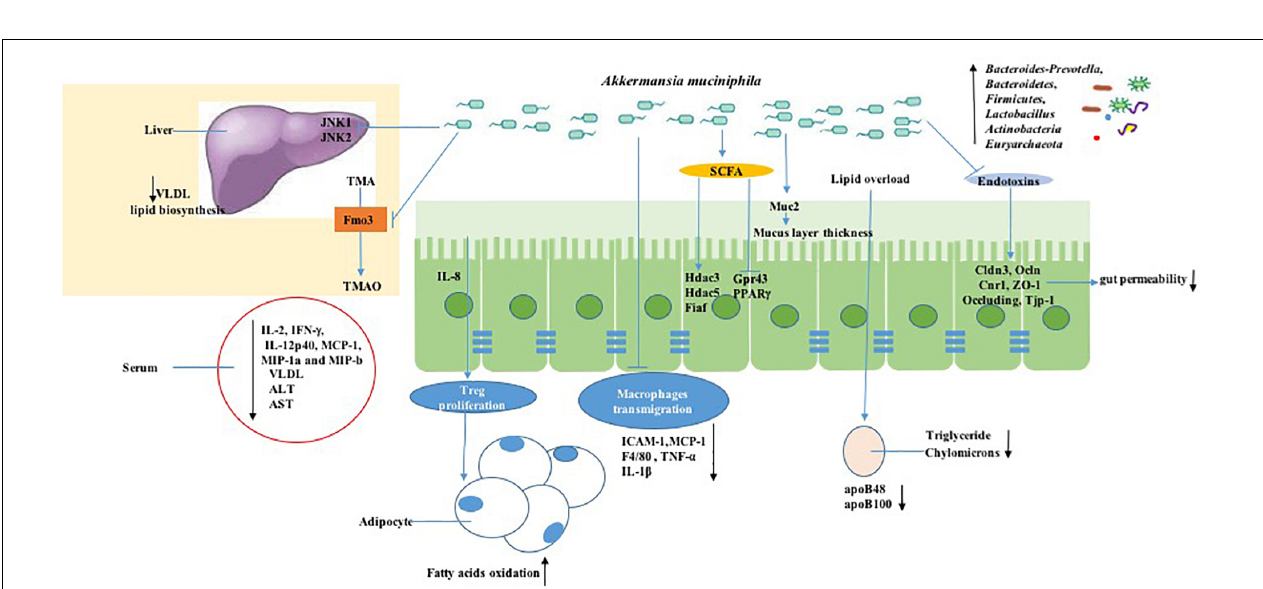
FIGURE 2 | Cross talk in host- A. muciniphila interactions and the associated improvement in obesity disease. After the colonization of A. muciniphila , the state of homeostasis and symbiotic relationships is improved by immunity activity. This state includes obesity and its associated liver disorder changes in the host; the gut barrier is restored either physically (at the mucous layer or the level of tight junctions) or at the level of the gut ecosystem, and reduced inflammatory responses are often induced by endotoxemia or LPS via TLRs and downstream cytokines, which improve intestinal permeability. TG, total triglyceride; ALT, Alanine Aminotransferase; AST, Aspartate Aminotransferase; LPS, lipopolysaccharide; TLR, Toll-like receptors; IFN γ , Interferon- γ ; TNF, tumor necrosis factor, IL-2, interleukin-2.